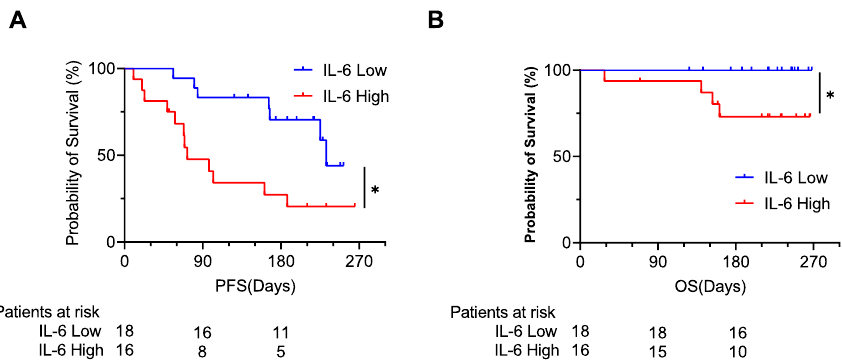
Figure 2. The Kaplan–Meier curve for the progression-free survival (PFS) ( A ) and overall survival (OS) ( B ). The patients were divided into 2 groups by the median value of plasma IL-6. * p < 0.05.